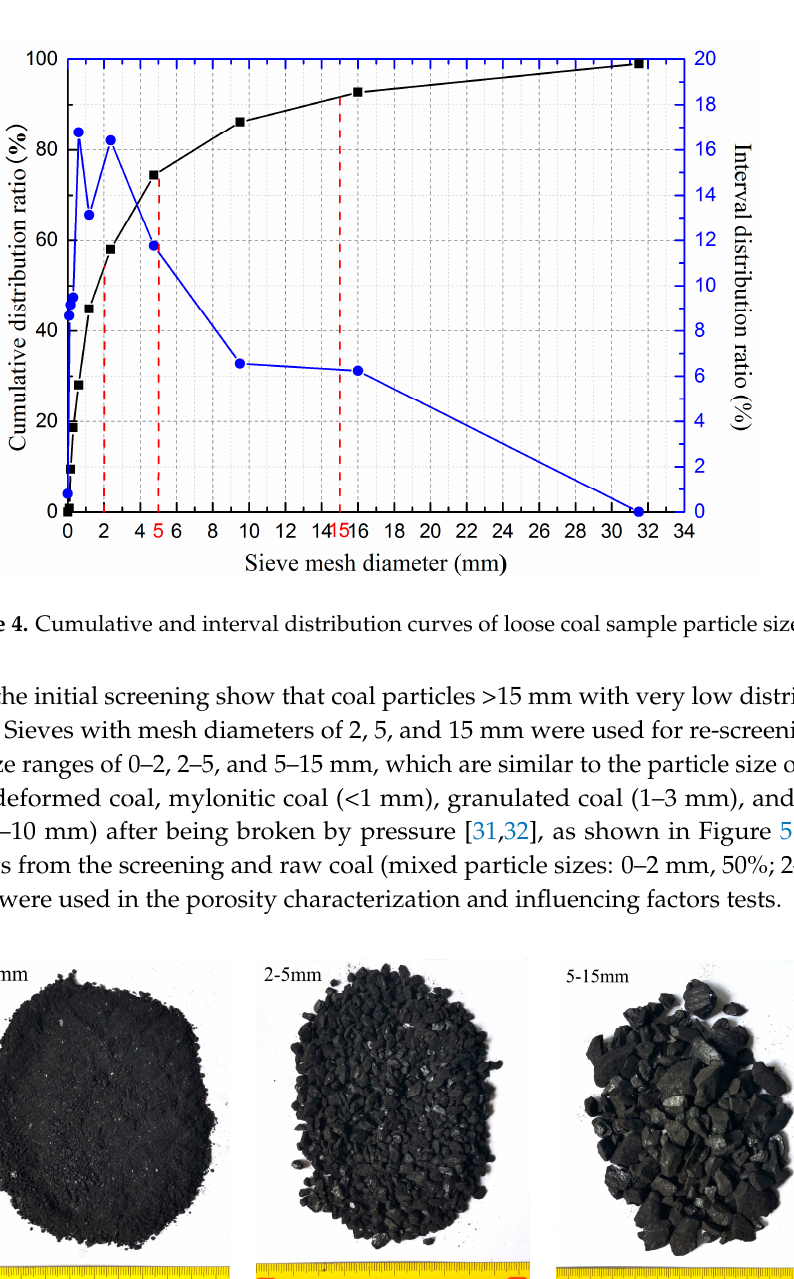
Figure 5. Screened coal particles of three different particle size classes.